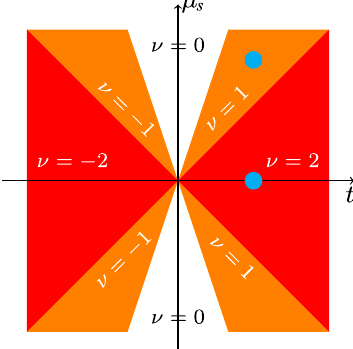
( − μ ) s s FIG. 9. Phase diagram of the lattice model defined by Eqs. (21) – )26 ), as a function of the staggered chemical potential μ and the s next-nearest-neighbor hopping t [Eqs. (22) – (24)]. There are 3 t separating different t and μ critical lines at μ s ¼ (cid:5) s ¼ (cid:5) topological phases with winding numbers ν ¼ − 2 ; − 1 , 0, 1, 2. For ν ¼ 2 , the bulk gap is largest (and therefore the surface 0 and finite t > 0 . The ν ¼ 1 penetration depth smallest) at μ s ¼ phase is narrower in phase space and harder to observe in ED numerics due to the larger penetration depth. The blue dots indicate the ν ¼ 2 and ν ¼ 1 parameters investigated in Figs. 10 and